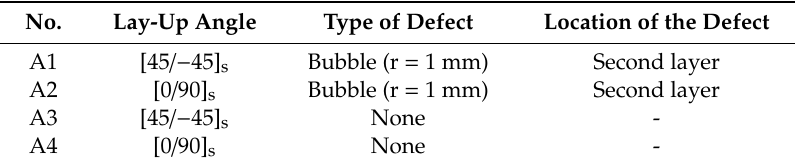
Table 1. Serial number of specimens and their defects.